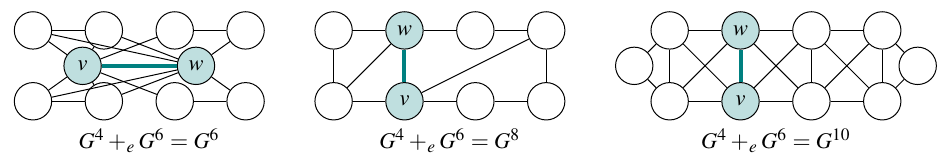
Figure 5. Gluing G 4 and G 6 via vertex v .